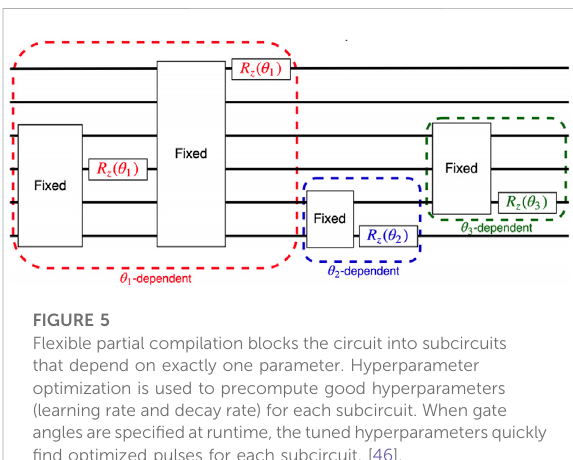
FIGURE 5 Flexible partial compilation blocks the circuit into subcircuits that depend on exactly one parameter. Hyperparameter optimization is used to precompute good hyperparameters (learning rate and decay rate) for each subcircuit. When gate anglesarespeci fi edatruntime,thetunedhyperparametersquickly fi nd optimized pulses for each subcircuit. [46].